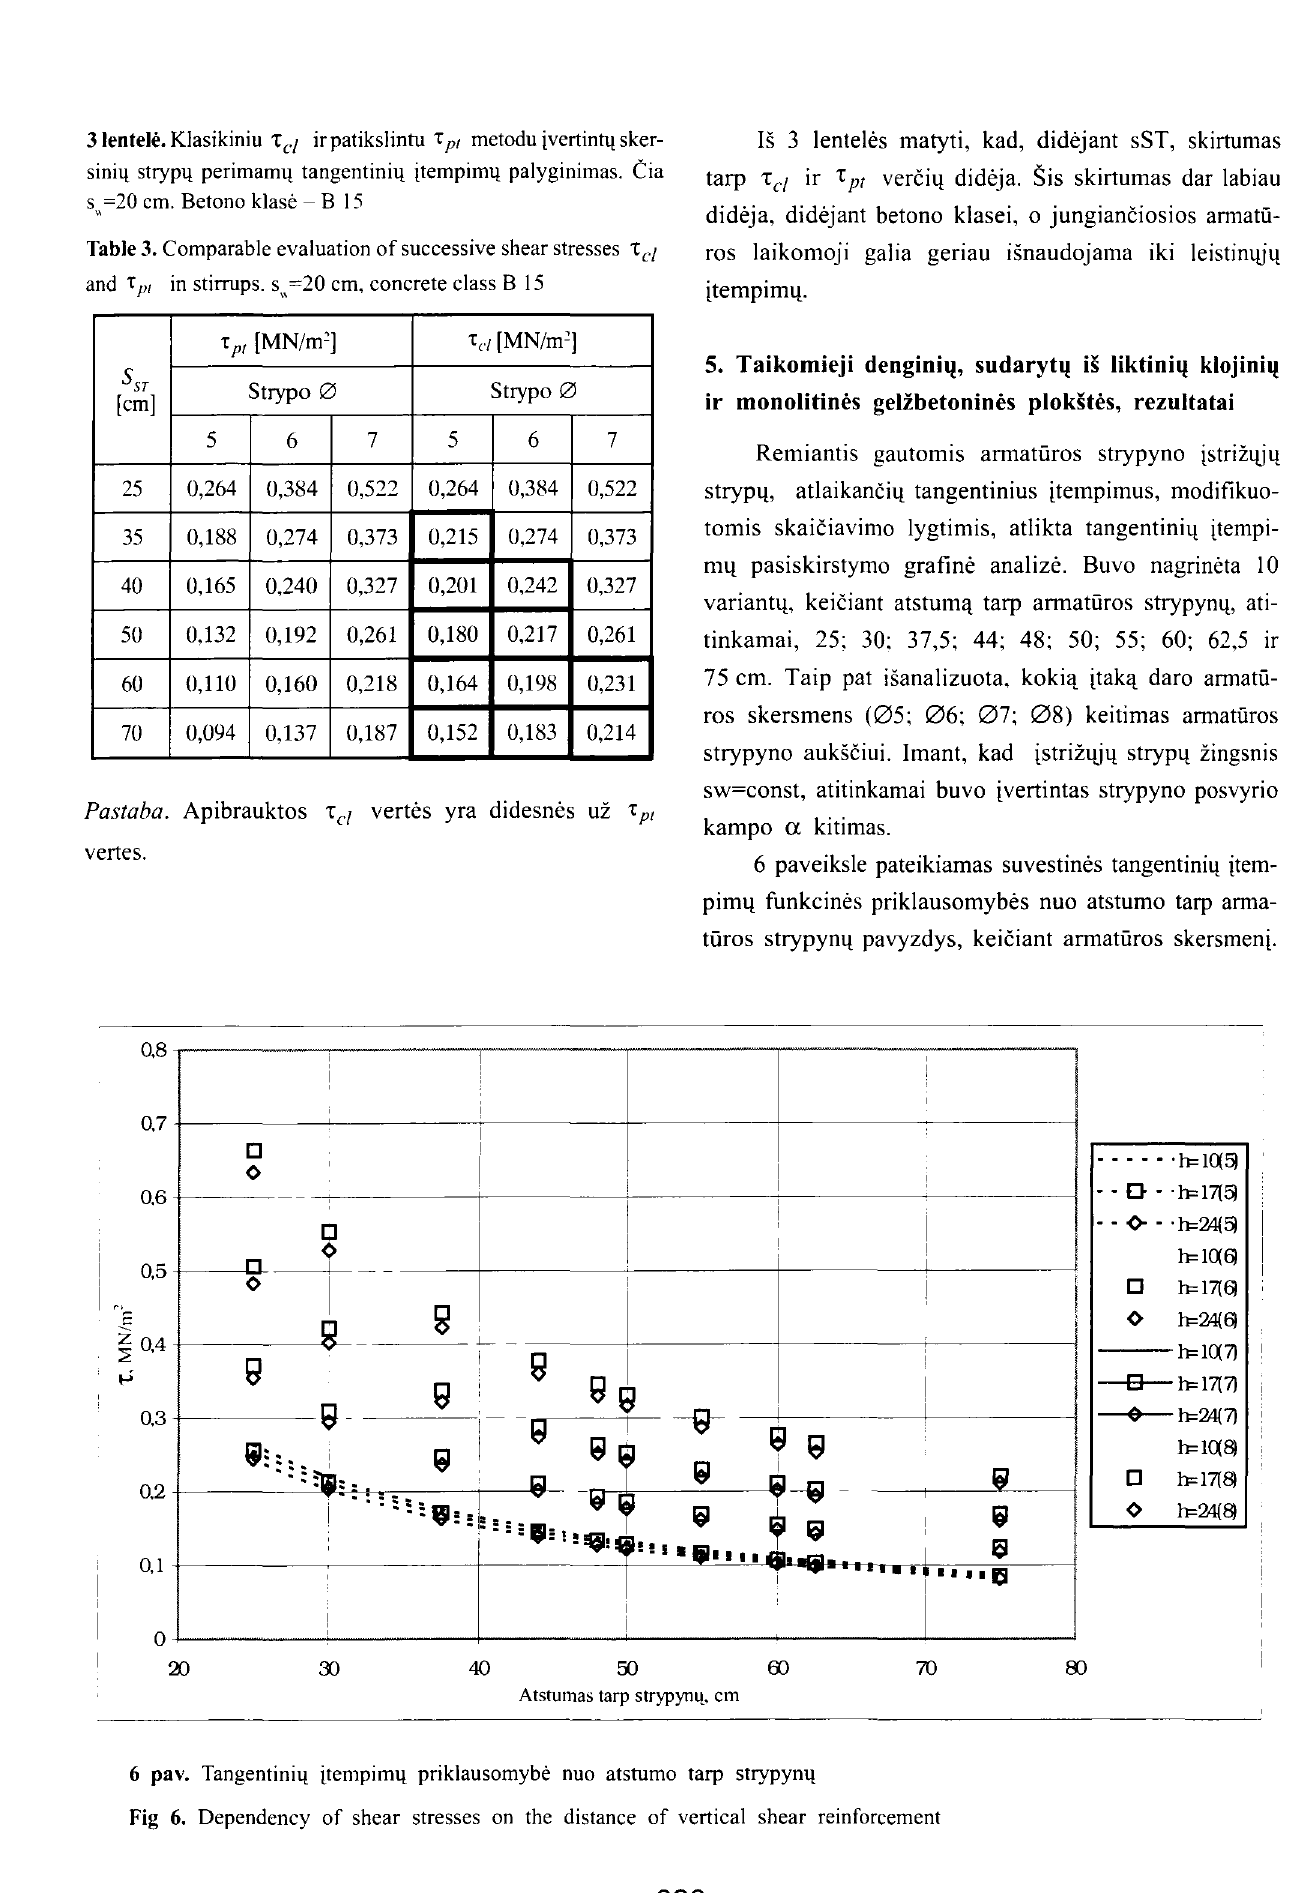
Table 3. Comparable evaluation of successive shear stresses 'tel and r p in stirrups. s" =20 em, concrete class B 15 1